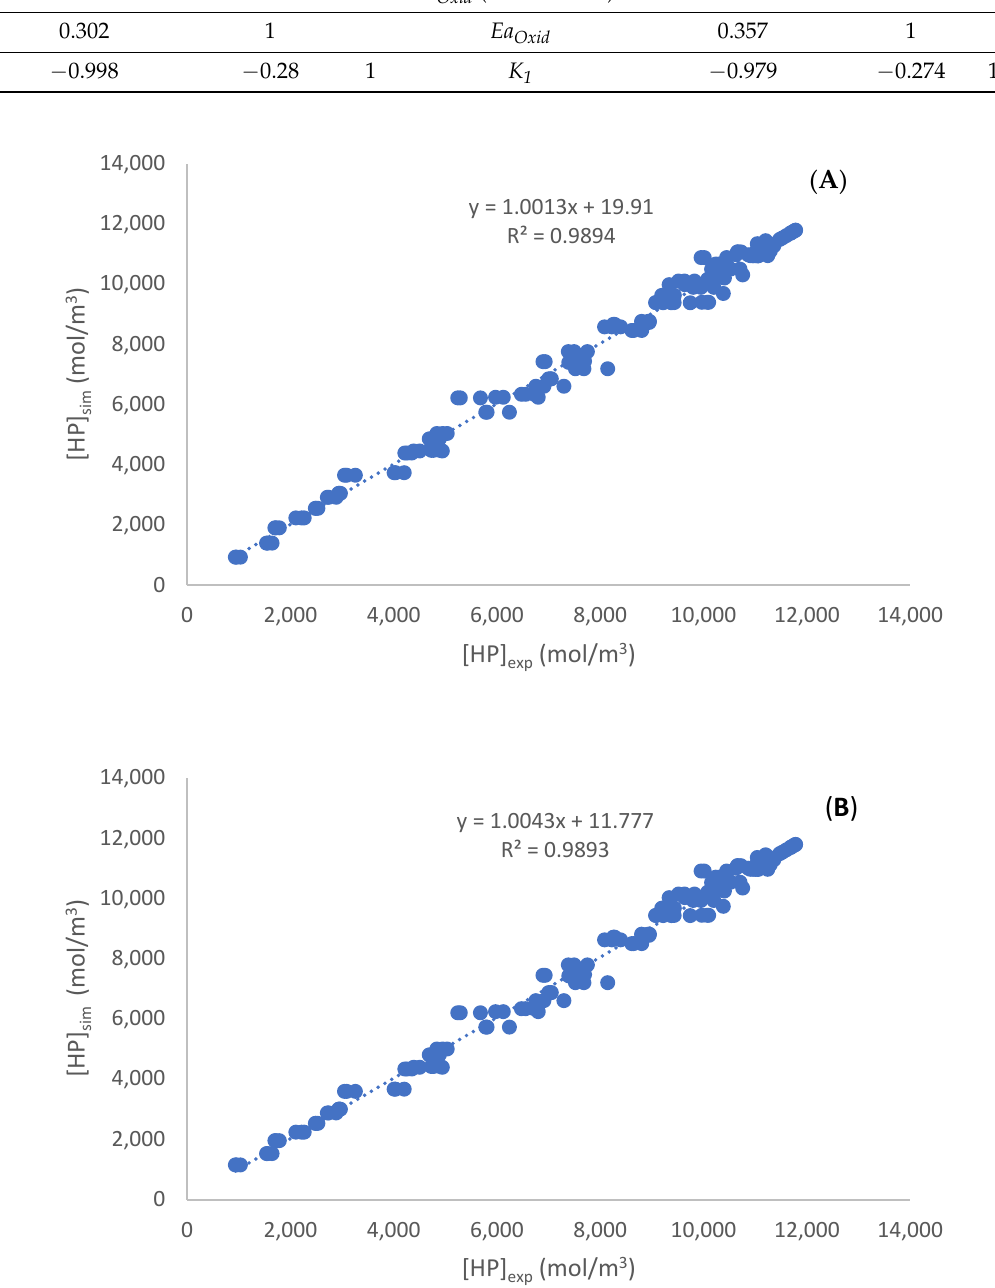
Table 5. Normalized covariance matrix for the estimated kinetic constants for Models a and b for the homogeneous liquid phase system. Model a Model b Kinetic Constants